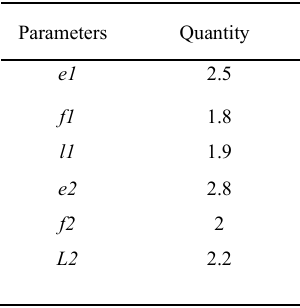
FIGURE 12. Reconfigurable SIW filter loaded with two different sizes C- HMCs using two PIN diodes (D1 and D2). TABLE II. Dimensions of reconfigurable SIW tunable filter with 2 PIN diodes (D1 and D2), (unit: